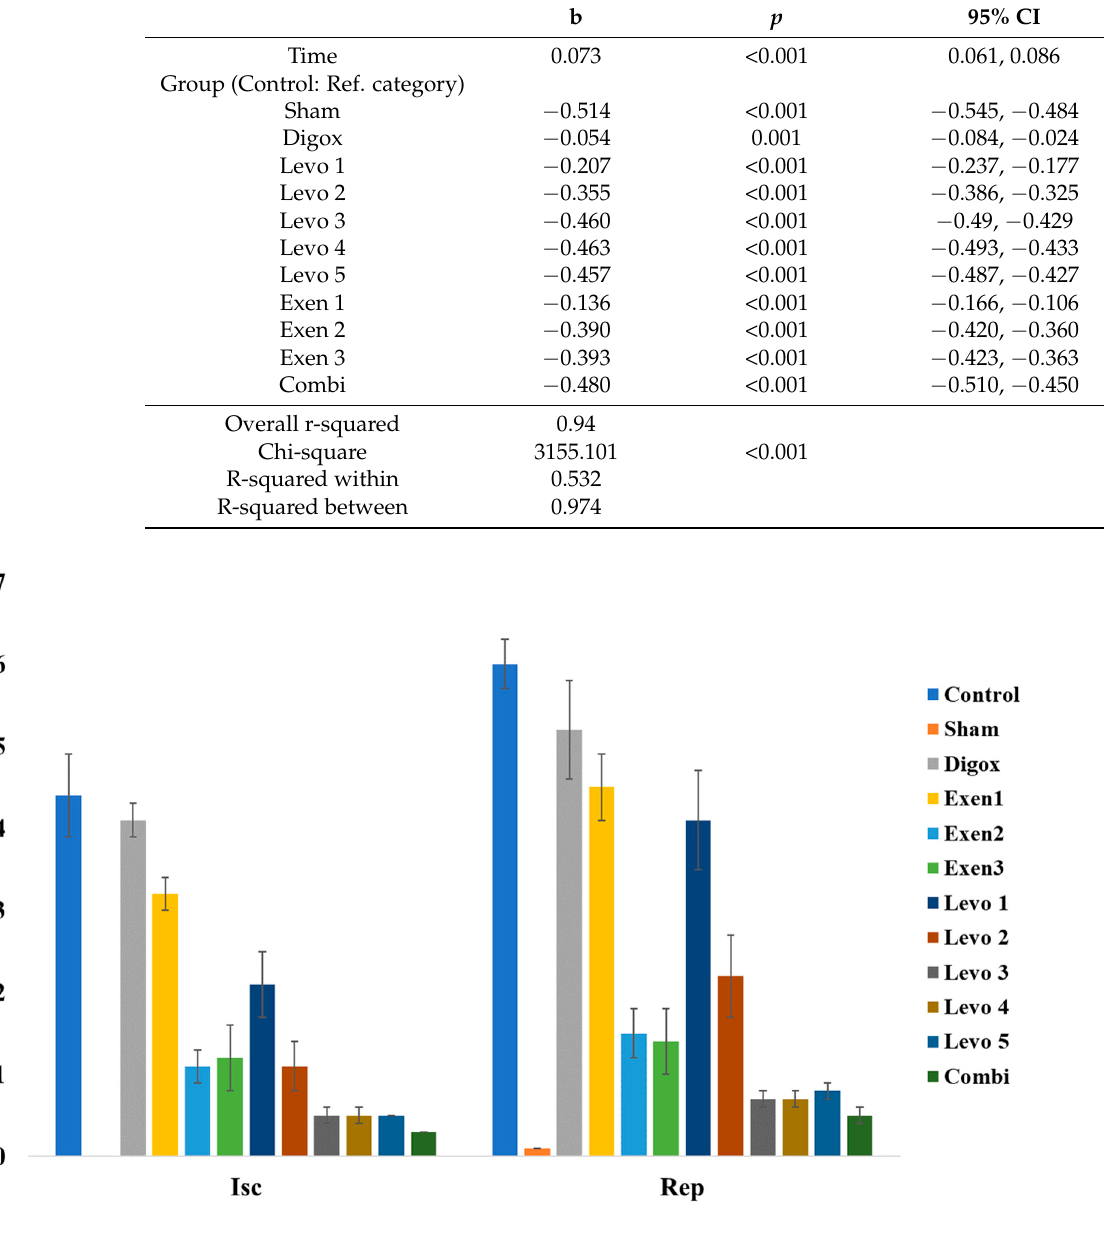
Table 12. Longitudinal analysis for CK-MB for all groups.